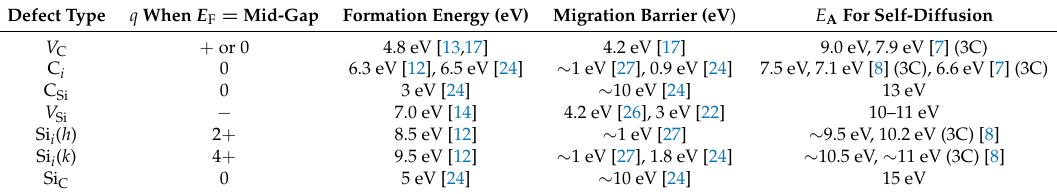
Table 1. Calculated activation energies ( E A ) for self-diffusion collected from the literature, defined as the sum of the formation energy and energy barrier for migration, via the various defect species available in 4H-SiC. During high-temperature annealing, the Fermi level ( E F ) is located near mid-gap in the 4H-SiC samples, and the formation energy is quoted for this value of E F . All formation energies are, wherever possible, quoted for Si poor and C rich conditions. Formation energies are quoted for HSE06 calculations, while the migration barriers are mostly deduced at